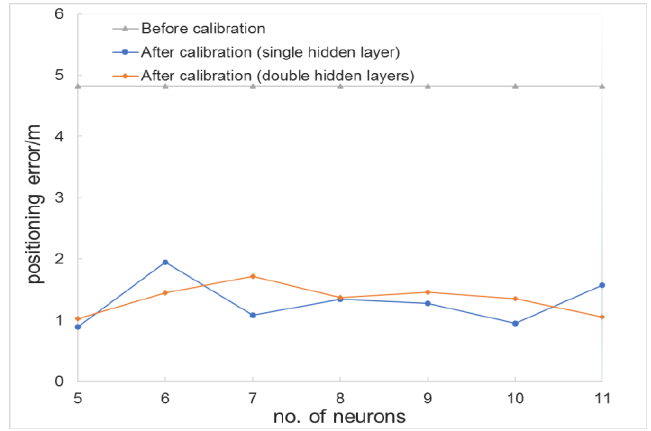
Figure 13. Comparison of average positioning error before and after calibration of test mobile terminal 2.